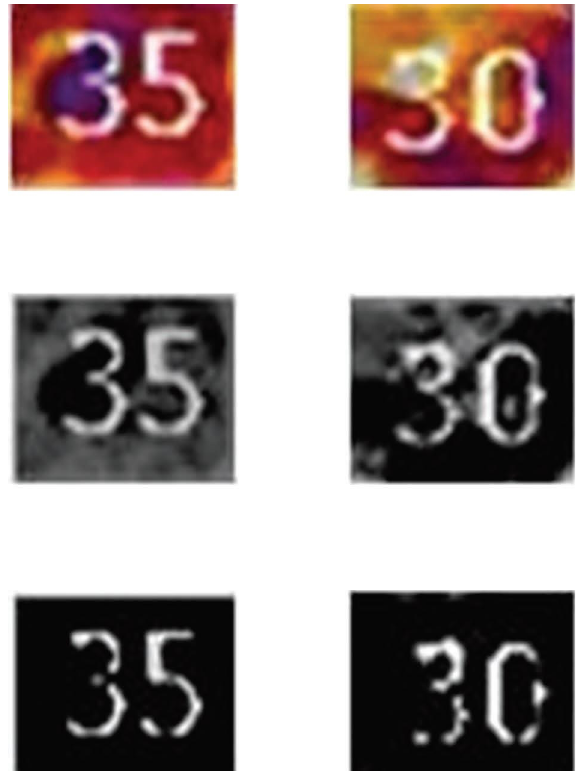
Figure 8: Sample of cropped boxes represent upper and lower temperature degrees, converted from RGB to gray and then to binary